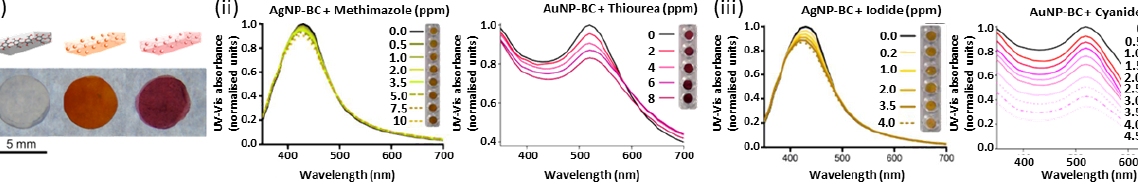
Figure 9. (i) Schematic representation (top) and photographical images of BC, AgNP – BC and AuNP – BC plasmonic nano-paper composites (from left to right). (ii) Change in UV-vis spectra and color of AgNP – BC paper composite upon addition of methimazole and of AuNP – BC upon addition of thiourea. (iii) Change in in UV-vis spectra and color of AgNP – BC upon addition of iodide and of AuNP-BC upon addition of cyanide [121]. Copyrights: all the images have been adapted and repro- duced with permission from © 2015, American Chemical Society.